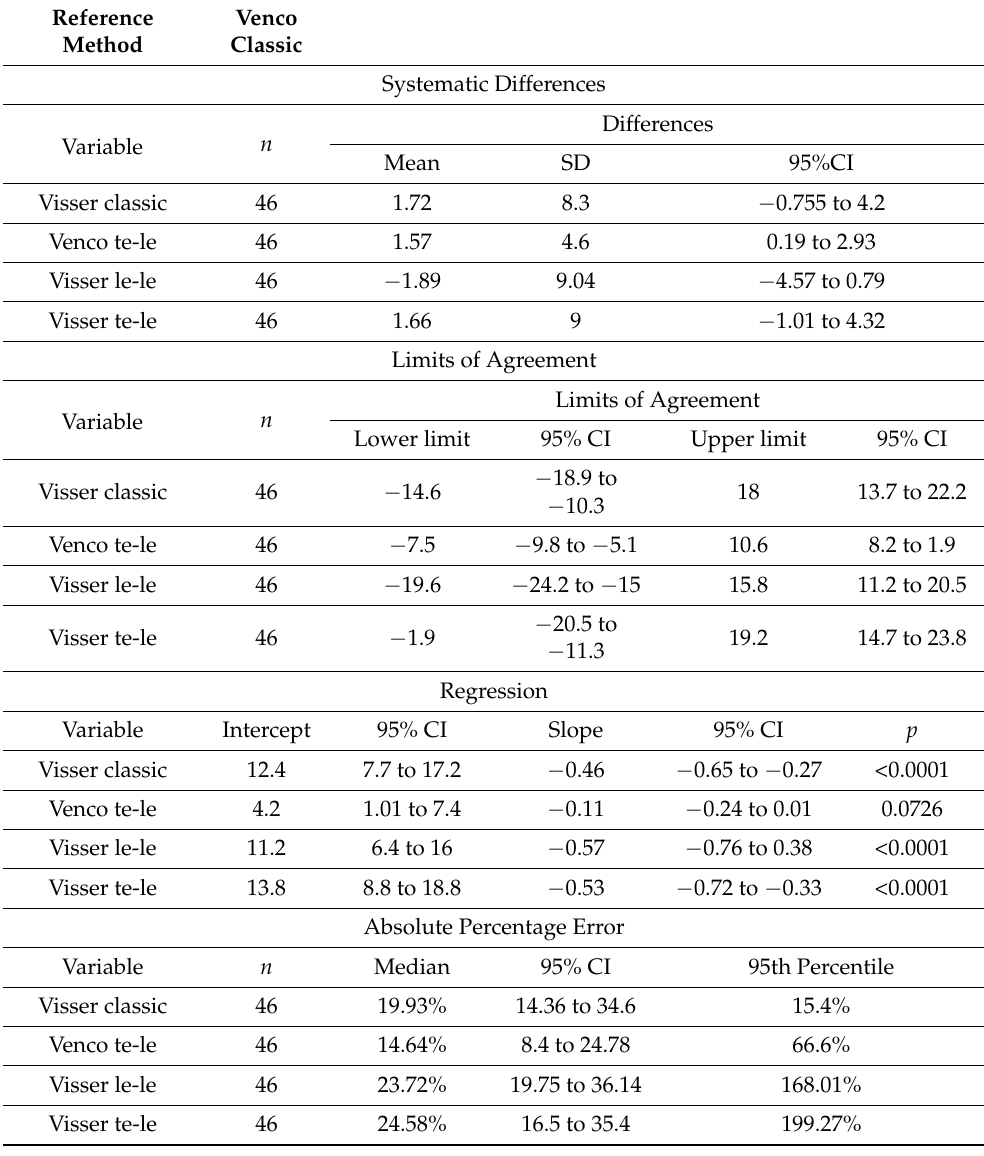
Table 2. Results of Multiple Variable Bland–Altman